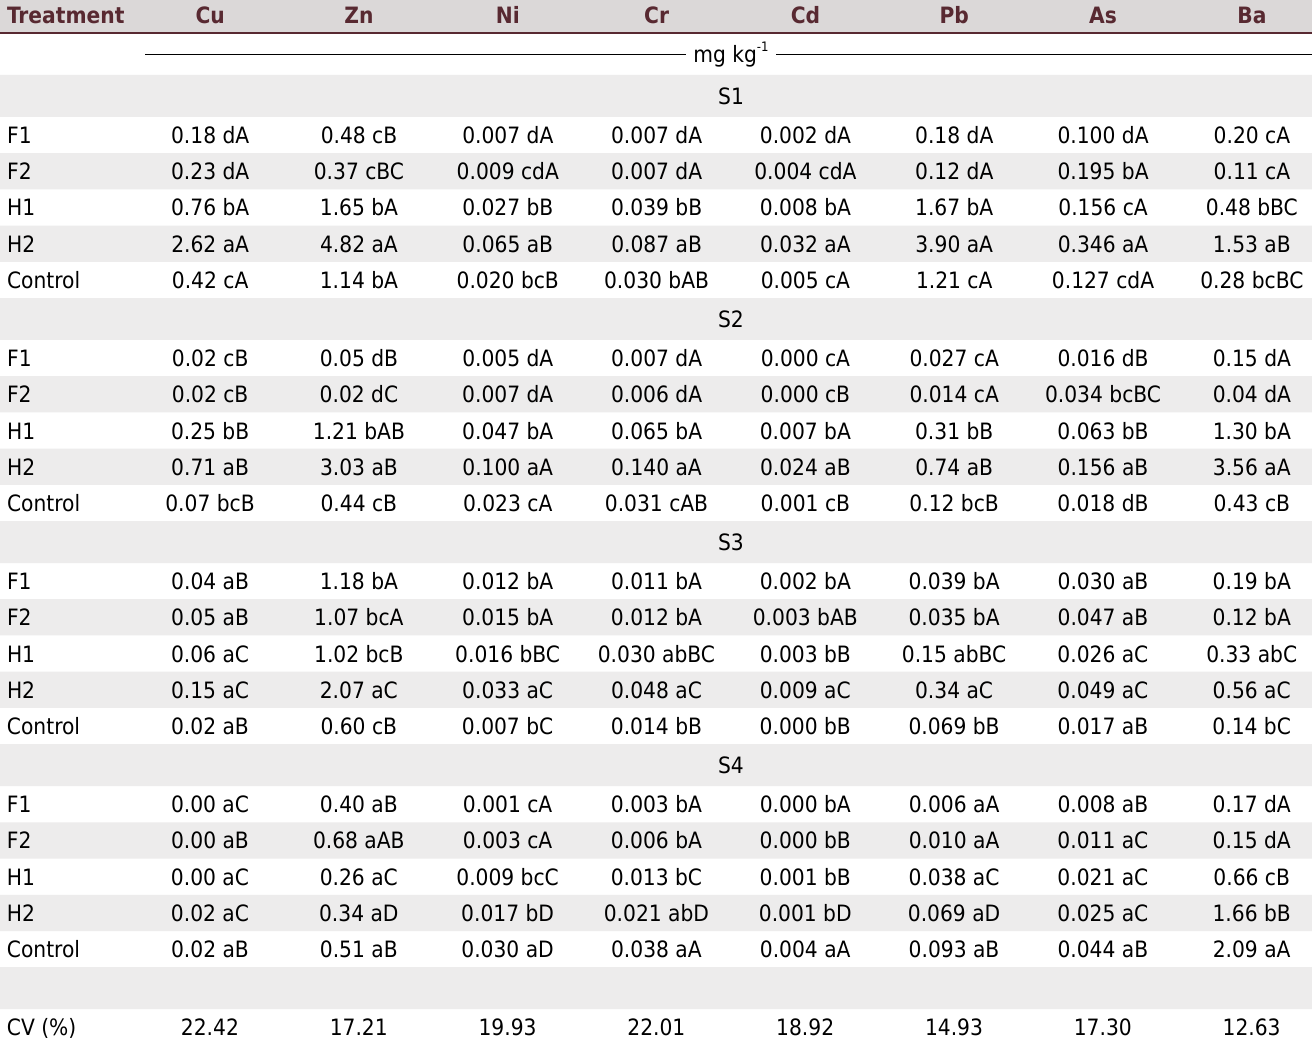
Table 4. Soluble heavy metals and metalloid contents in soil samples (S1, S2, S3 and S4) from a multi-metal contaminated site after application of doses of humic acid and fulvic acid